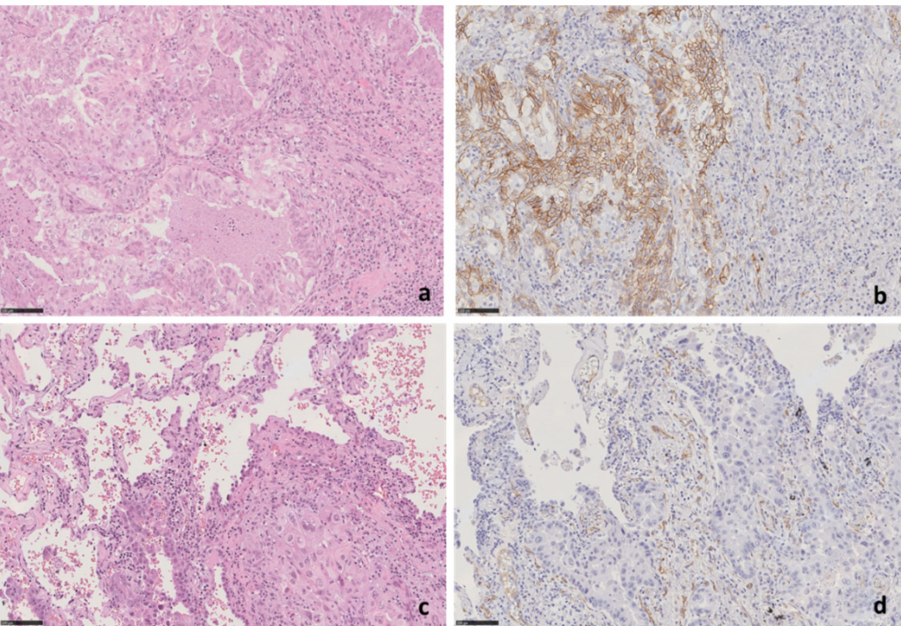
Figure 8. SPARC protein expression by immunohistochemical analysis. ( a , b ) Morphological features of case (LCCH-773) of lung adenocarcinoma, negative for SPARC promoter methylation, showing strong SPARC expression. ( a ) H&E staining, original magnification 20 × ; ( b ) SPARC staining, 20 × original magnification. ( c , d ) Morphological features of case LCCH-889 of lung